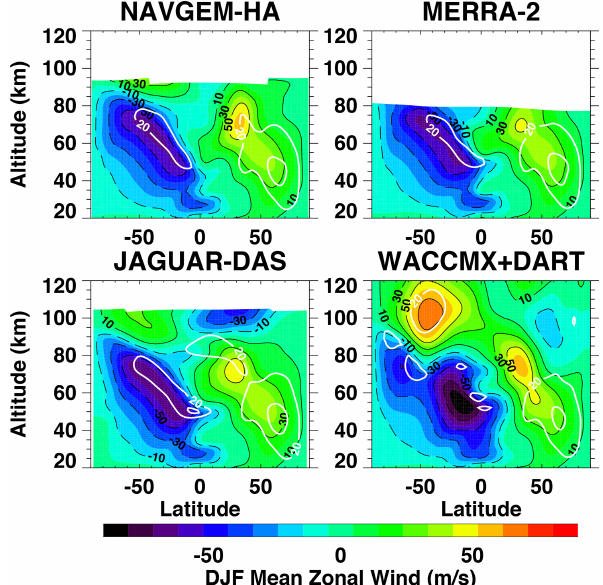
Figure 2. Latitude–altitude cross-sections of DJF 2009–2010 average zonal mean temperature in NAVGEM-HA, MERRA-2, JAGUAR-DAS, and WACCMX + DART. Thick white contours are temperature standard deviation values of 10 and 20K.